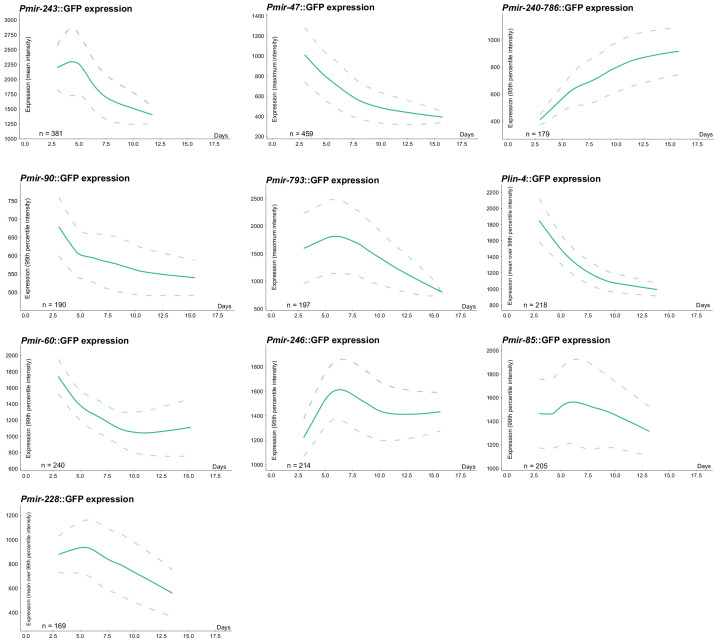
LOWESS trends for expression of predictive PmiRNA::GFP reporters over time (solid line) and standard deviation (dashed line).